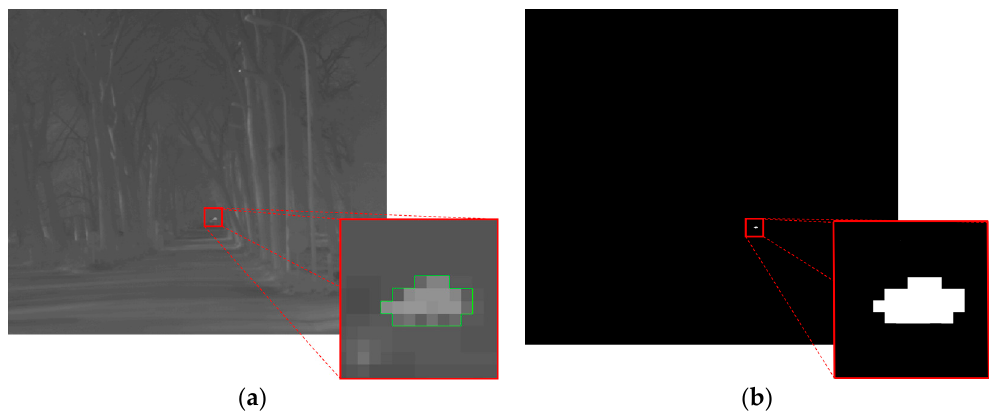
Figure 6. Example frame of a video sequence containing a slow moving object, contoured in green in the zoomed box ( a ); and corresponding detection map output by the proposed algorithm ( b ). Remote Sens. 2017 , 9 , 1128